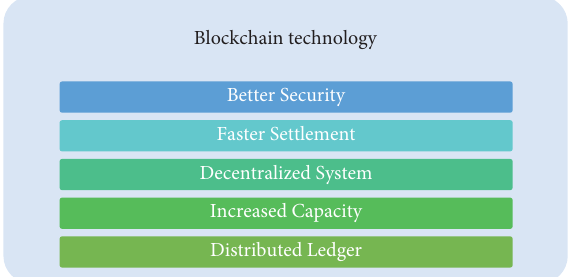
Figure 3: Summary of Blockchain technology